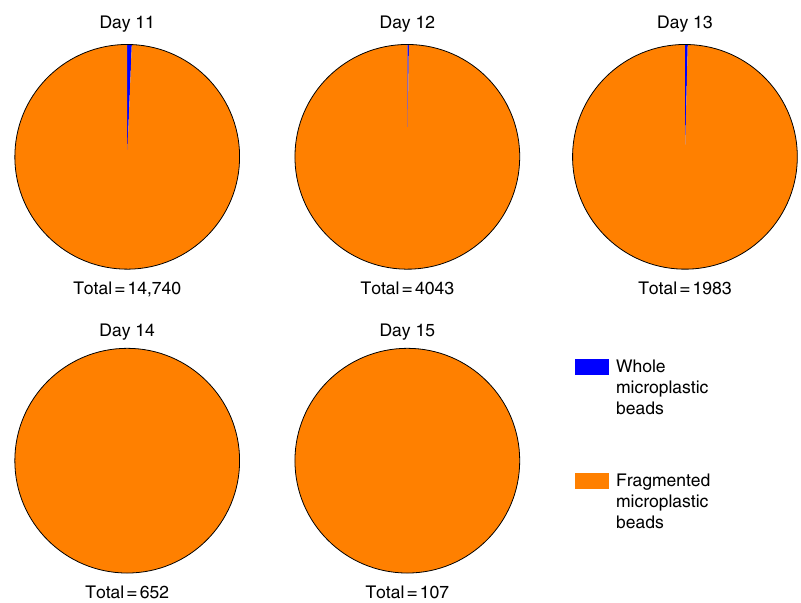
Fig. 4 The proportion of PE plastic fragments to whole beads isolated from Antarctic krill. Faecal material (from n = 15 krill) was collected over 5 days, after switching from 10 days of low dose microplastic exposure, with daily static renewal, to an uncontaminated algae diet. Total refers to the total number of particles measured in each 24 h period of faecal material. Fragments are shown in orange, while whole beads are shown in